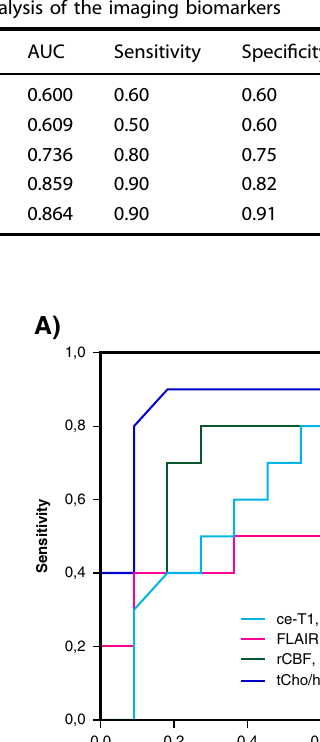
Fig. 2. The fractional change in tCho/hCr, rCBF, FLAIR volume, and ce- T1 volume at days +15 and +29 relative to baseline were further analyzed in relation to PFS and OS duration in Fig. 4. Spearman correlation analysis showed that fractional change of tCho/hCr was negatively correlated with OS at both day +15 ( P = 0.07, R = − 0.64) and day +29 ( P < 0.001, R = − 0.77). Fractional change of rCBF showed positive Spearman correlation at day +15 ( P = 0.03, R = 0.49) and day +29 ( P = 0.03, R = 0.46). There was a trend for